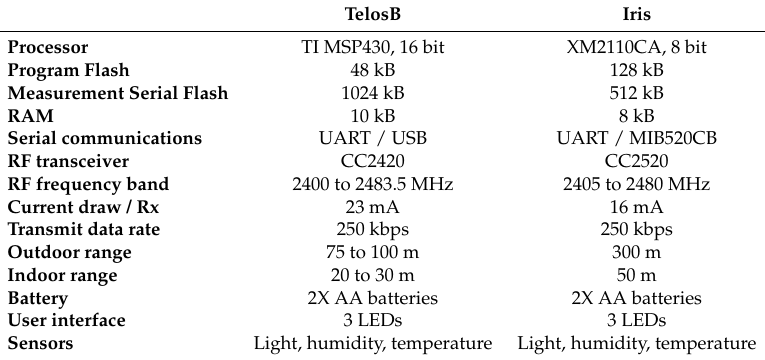
Table 6. Hardware technical